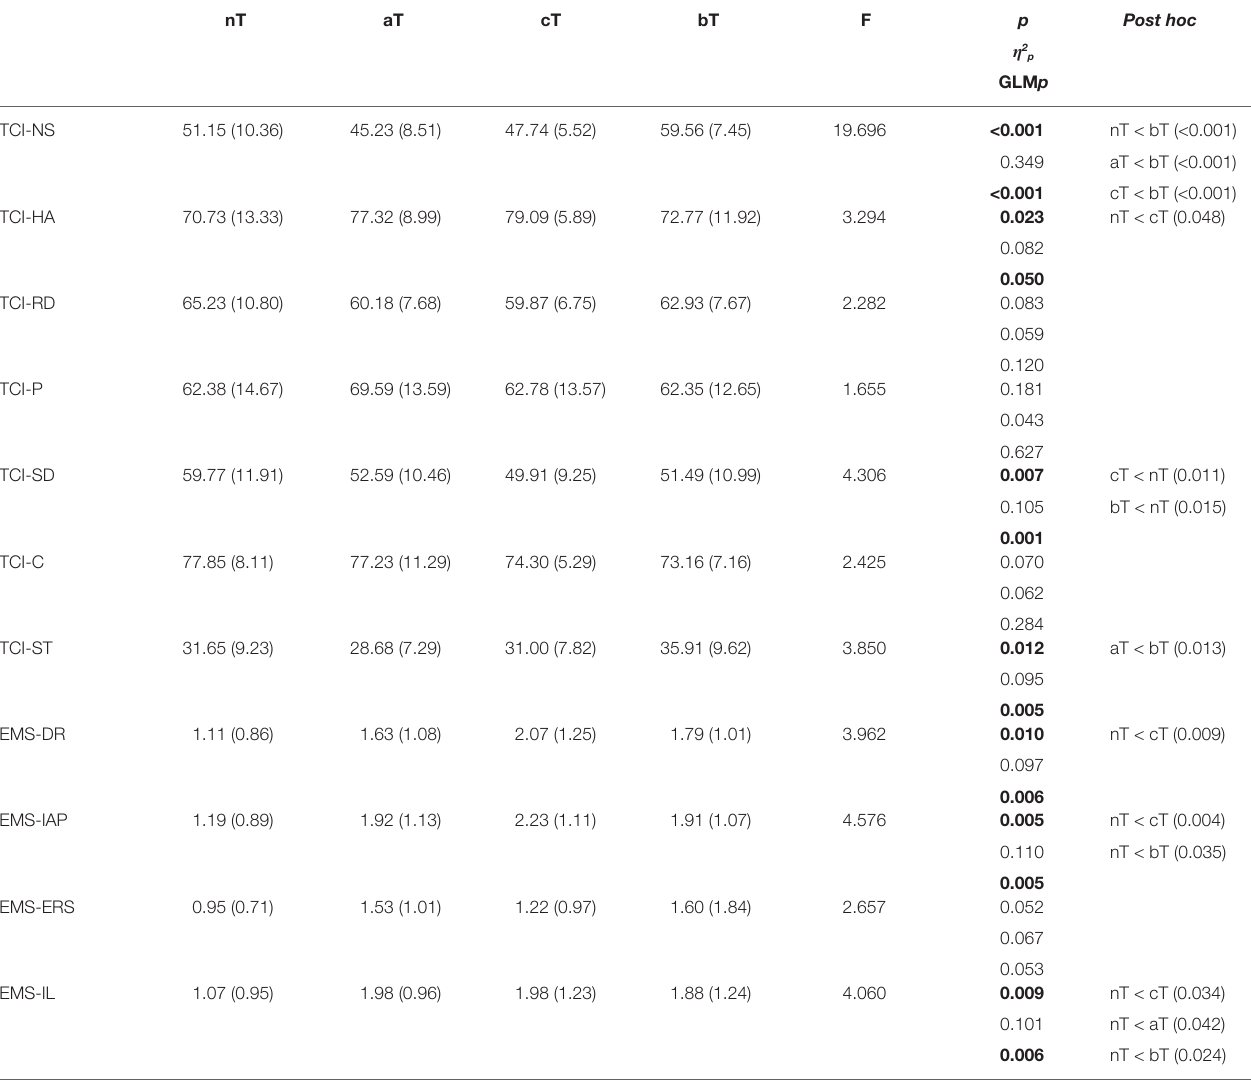
TABLE 3 | Personality traits and early maladaptive schemas (EMS) domains. nT aT cT